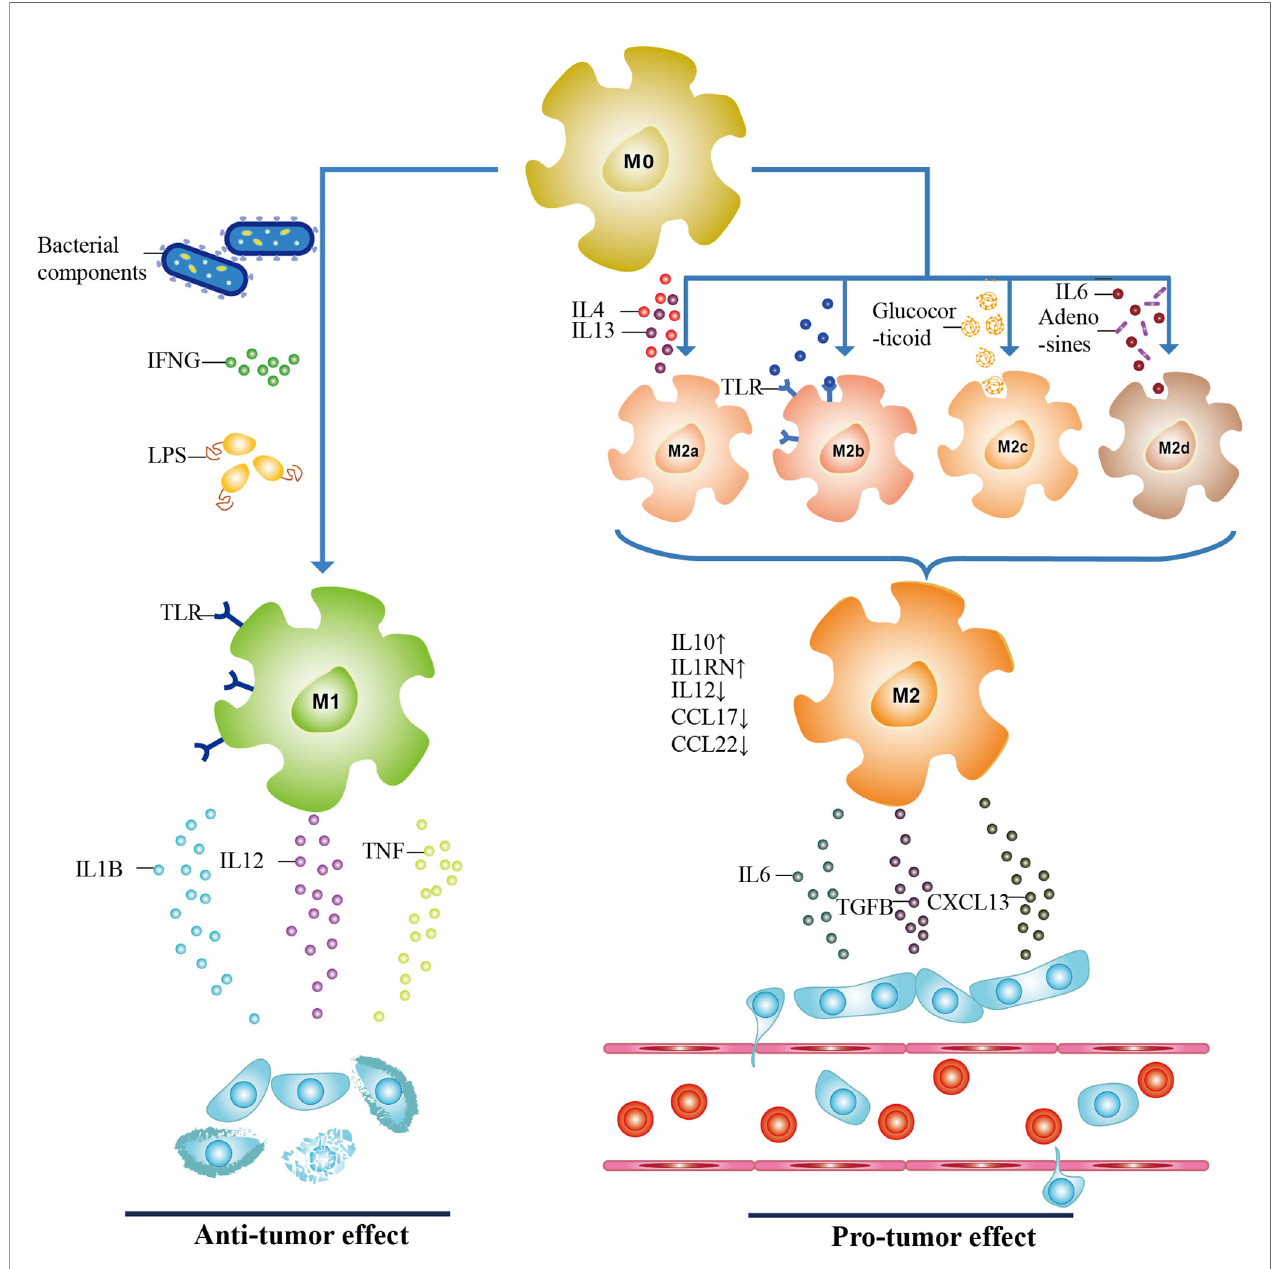
FIGURE 1 | The polarization of TAMs. TAMs have three subtypes, including undifferentiated macrophages (M0 phenotype), pro-in fl ammatory phenotype (M1 phenotype), and anti-in fl ammatory phenotype (M2 phenotype). When activated by bacterial components, interferon- g (IFNG), lipopolysaccharide (LPS), and Toll-like receptor (TLR), M0 macrophages are polarized toward M1 through classical activation. With a high expression of IL6 and CXCL8, and lower levels of CCL22, CCL17, and IL12, M2 macrophages are generated through alternative activation of M0 macrophages. Depending on stimulators, they can be further classi fi ed into M2a, M2b, M2c, and M2d subtypes. M1 and M2 phenotypes secret cytokines to participate in tumor progression, and the role of both in CRC is antagonistic to each other. It is con fi rmed that M1 macrophages act as the tumor suppressor while M2 phenotype promotes